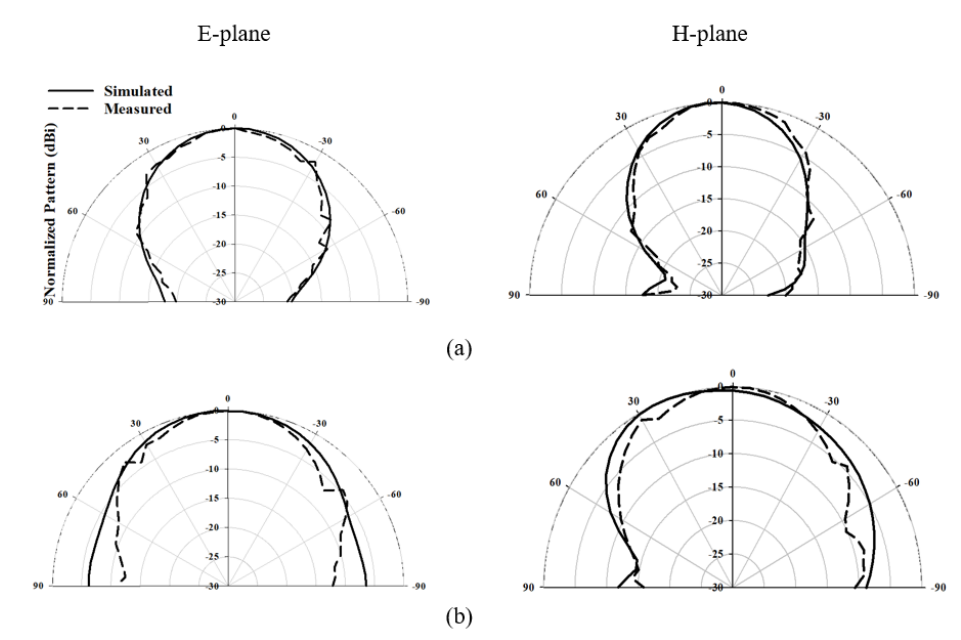
Figure 13. The E and H planes radiation patterns of a hemispherical DRA placed on a grooved compound ground plane ( a ) 22.7 GHz ( b ) 27